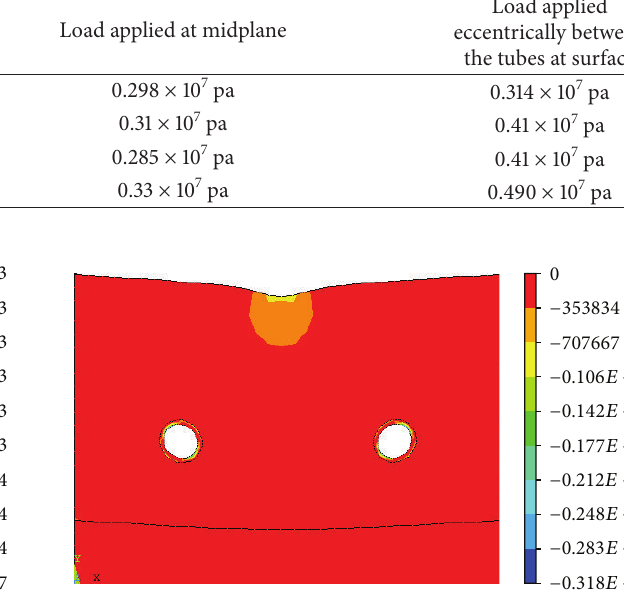
Figure 16: Strain distribution. Figure 17: Third principle